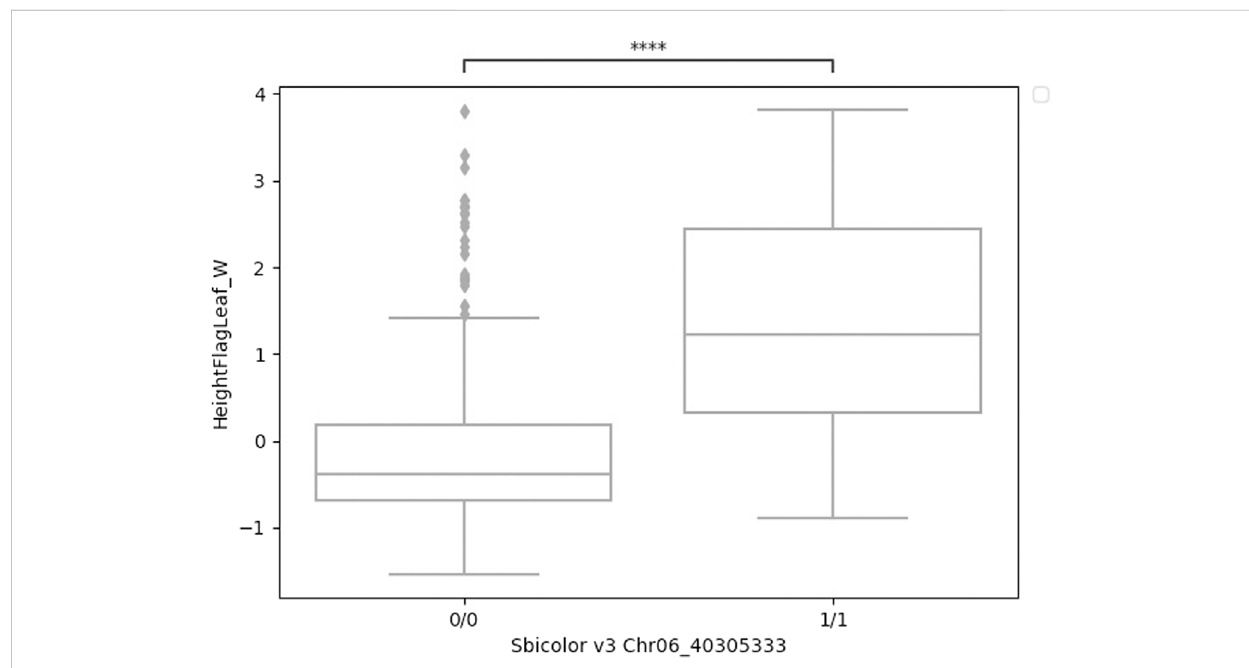
FIGURE 4 Boxplots of height to fl ag leaf best linear unbiased predictions by genotype (either homozygous reference 0/0 or homozygous alternative 1/1) for a four-base deletion in Ma1 at Chr06_40305333. These two groups were signi fi cantly different ( t -test) at p < 0.001.